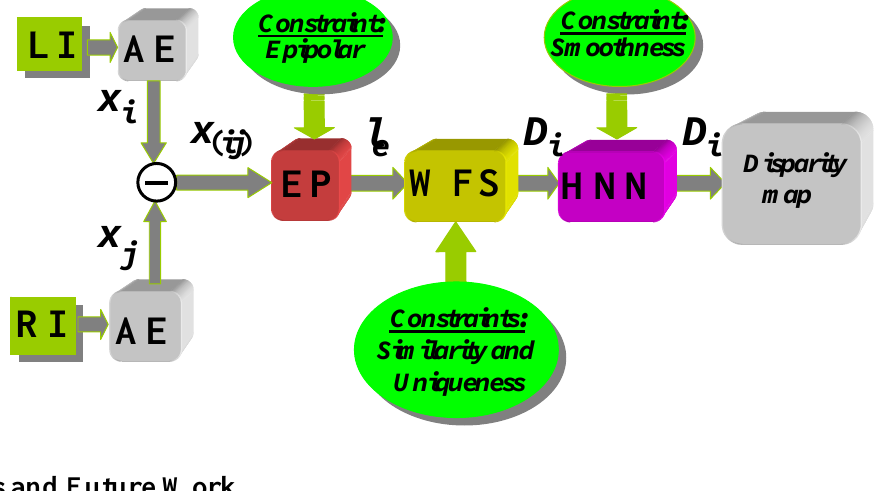
Figure 6. Proposed stereoscopic matching process based on